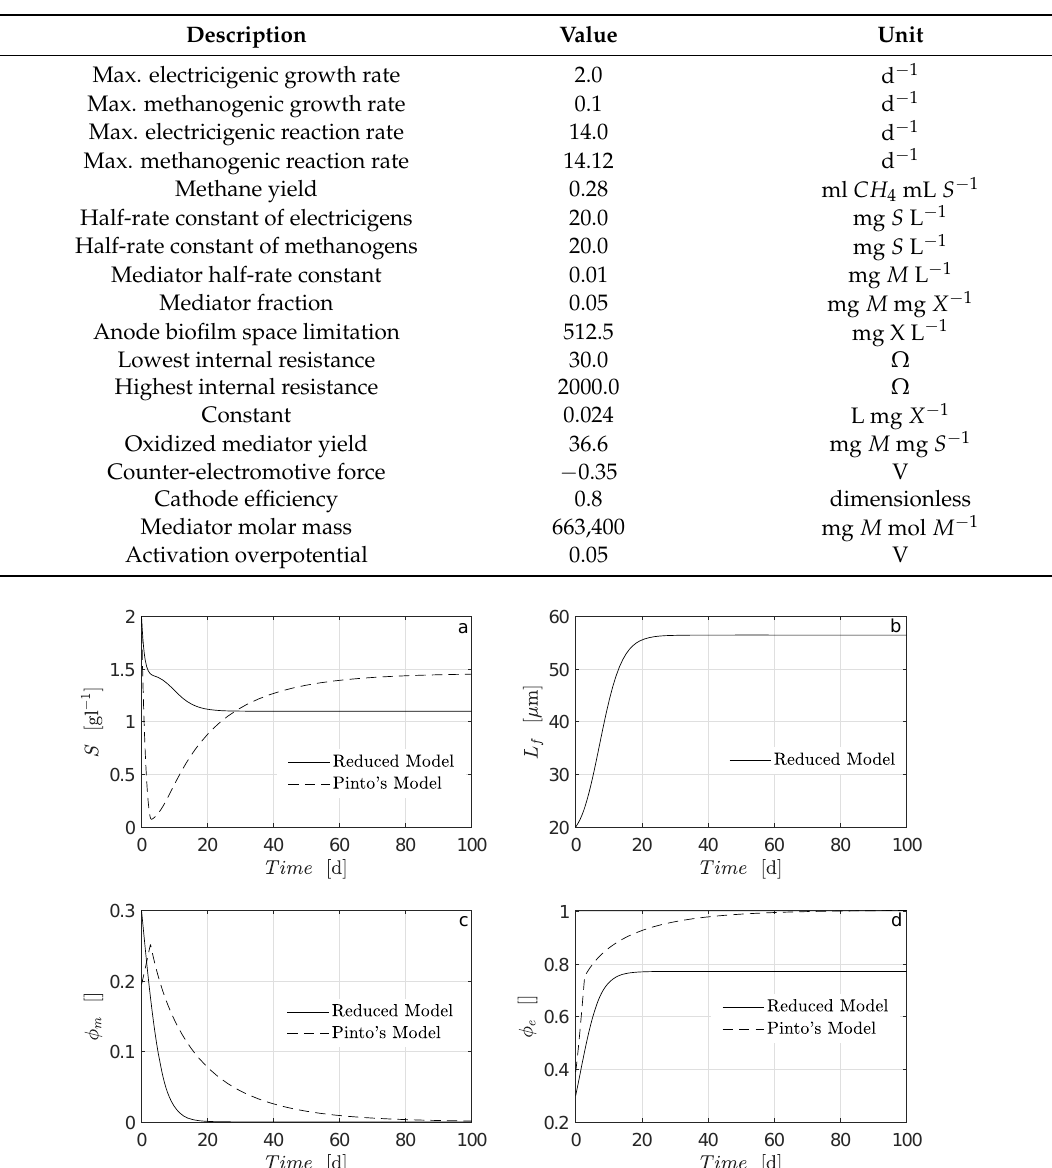
Table 7. Set of parameters for model in (23) and auxiliary functions in (24).